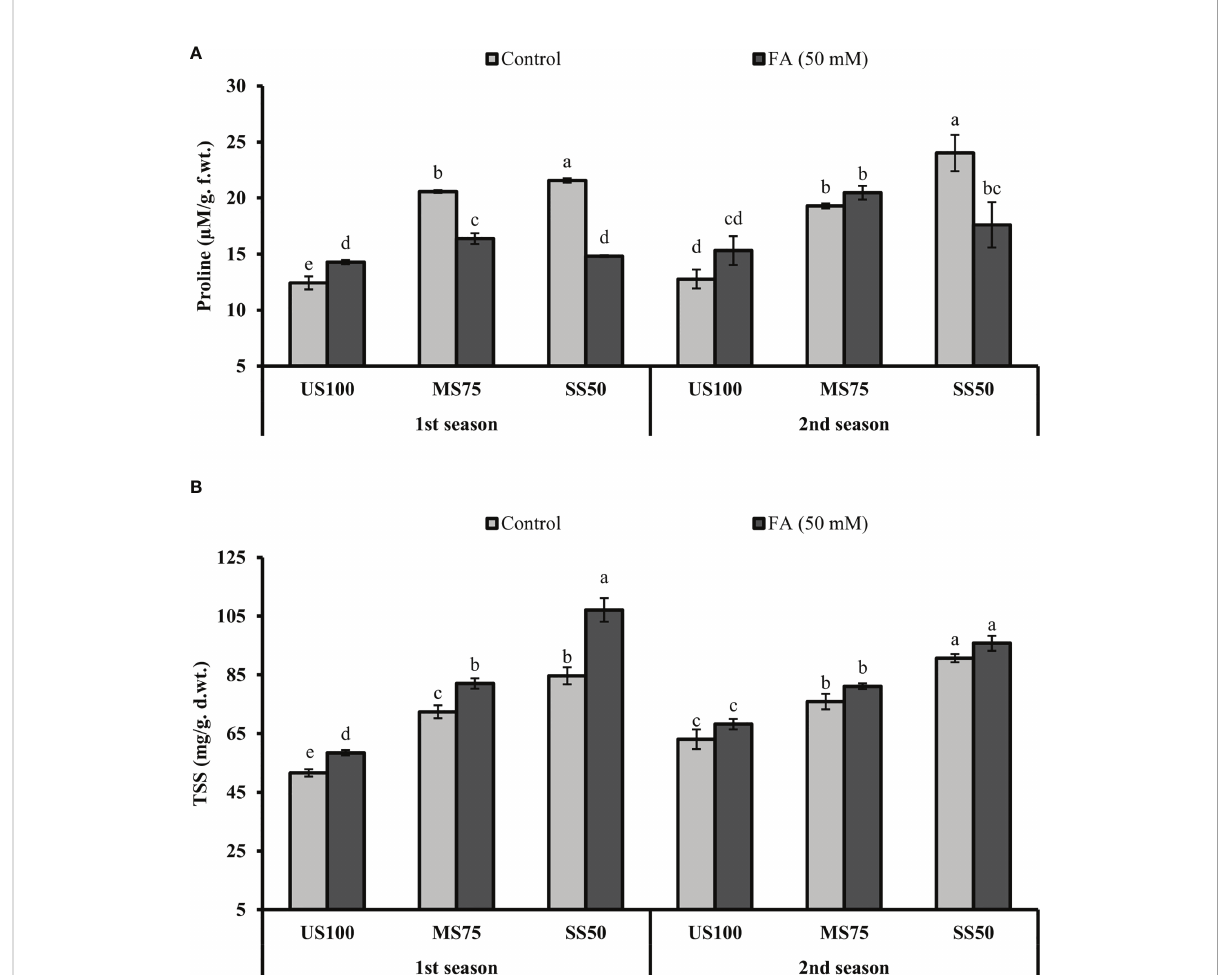
FIGURE 9 Effect of foliar application of folic acid (50 mM) on osmolytes (A) proline and (B) total soluble sugars in the fi rst and second seasons. The graph values are the mean ± SE of four replicates. The bars exhibited with different letters indicate a signi fi cant difference between samples by least signi fi cant difference ( p ≤